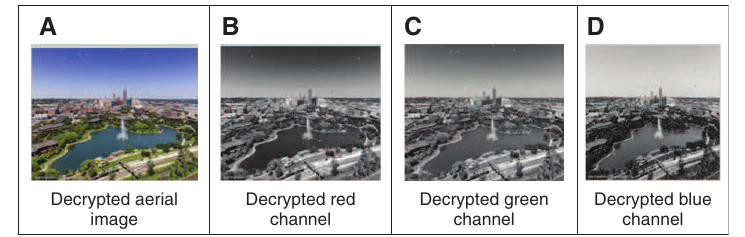
Figure 4: (A–D) Decrypted “Aerial” Image with R, G, and B